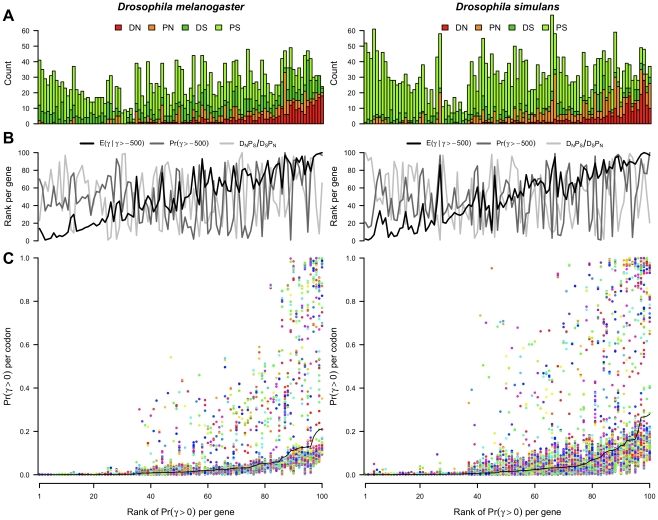
The posterior probability of positive selection across genes and codons.(A) The number of non-synonymous substitutions (DN) and polymorphisms (PN) and synonymous substitutions (DS) and polymorphisms (PS) per gene in the D. melanogaster and D. simulans lineages. (B) The rank per gene of various measures of selection. : mean selection coefficient at viable sites. : proportion of sites viable. : odds ratio of the McDonald-Kreitman table. (C) , the posterior probability of positive selection per codon (points) and per gene (black line). Points are colored randomly to aid visualization. In (A), (B) and (C), genes are ordered horizontally by the rank of  per gene.